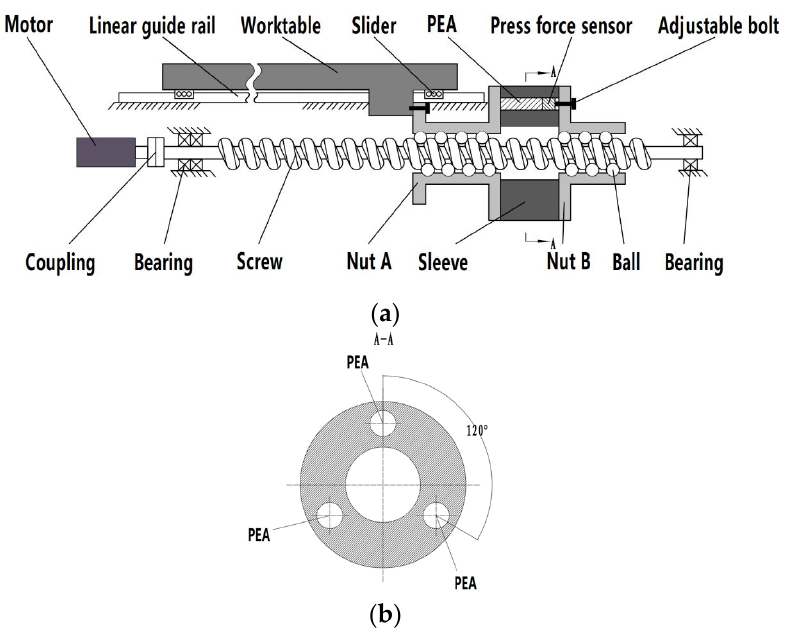
Figure 1. The schematic diagram of the variable preload force ball screw system: ( a ) overall configuration of the variable preload force ball screw system; ( b ) section view.